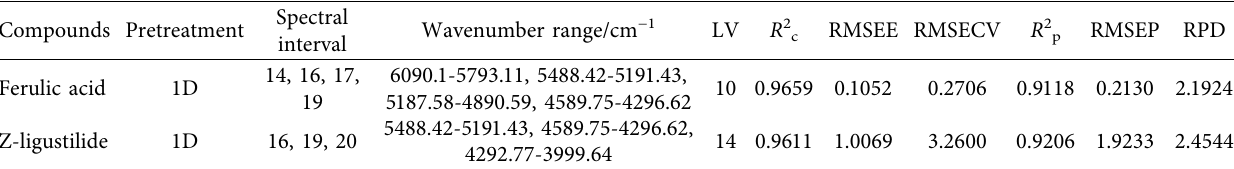
Table 5: Performance of the optimized PLSR models for the determination of ferulic acid and Z-ligustilide contents in ASR using FT-NIR based on selected spectral intervals combinations and pretreated methods. Compounds